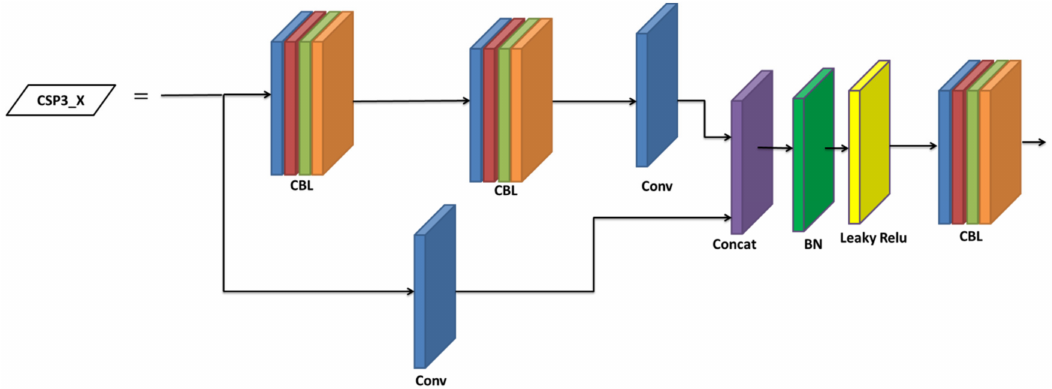
Figure 6. Architecture of the CSP3_X module.